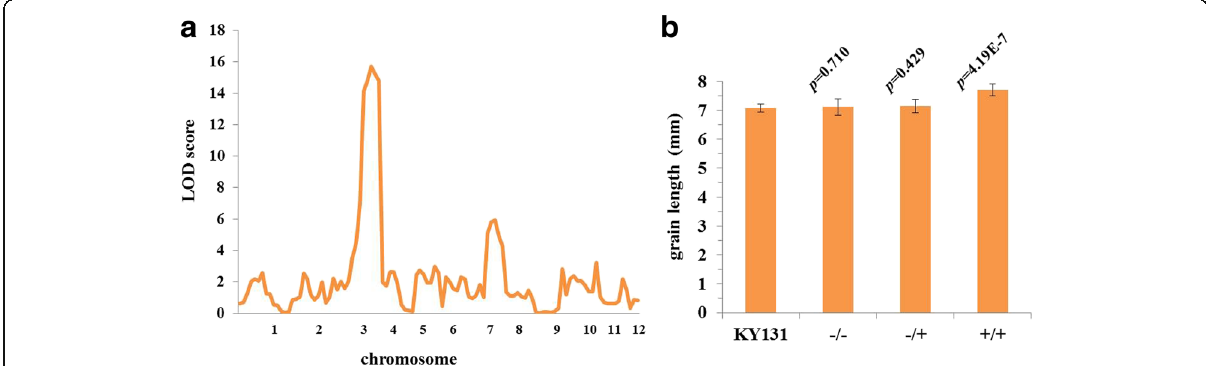
Fig. 1 QTL analysis detected a locus related grain length nearby the GS3 locus. a QTL analysis using F 2 population with 136 individuals and 123 SNP markers. b the grain length is significantly increased with the donor GKBR allele at the GS3 locus. n = 10. The values represent the mean ± s.d. p values from the student ’ s t -test of the plant with different genotype at GS3 locus against Kongyu131 is indicated. KY131 is the abbreviation of Kongyu